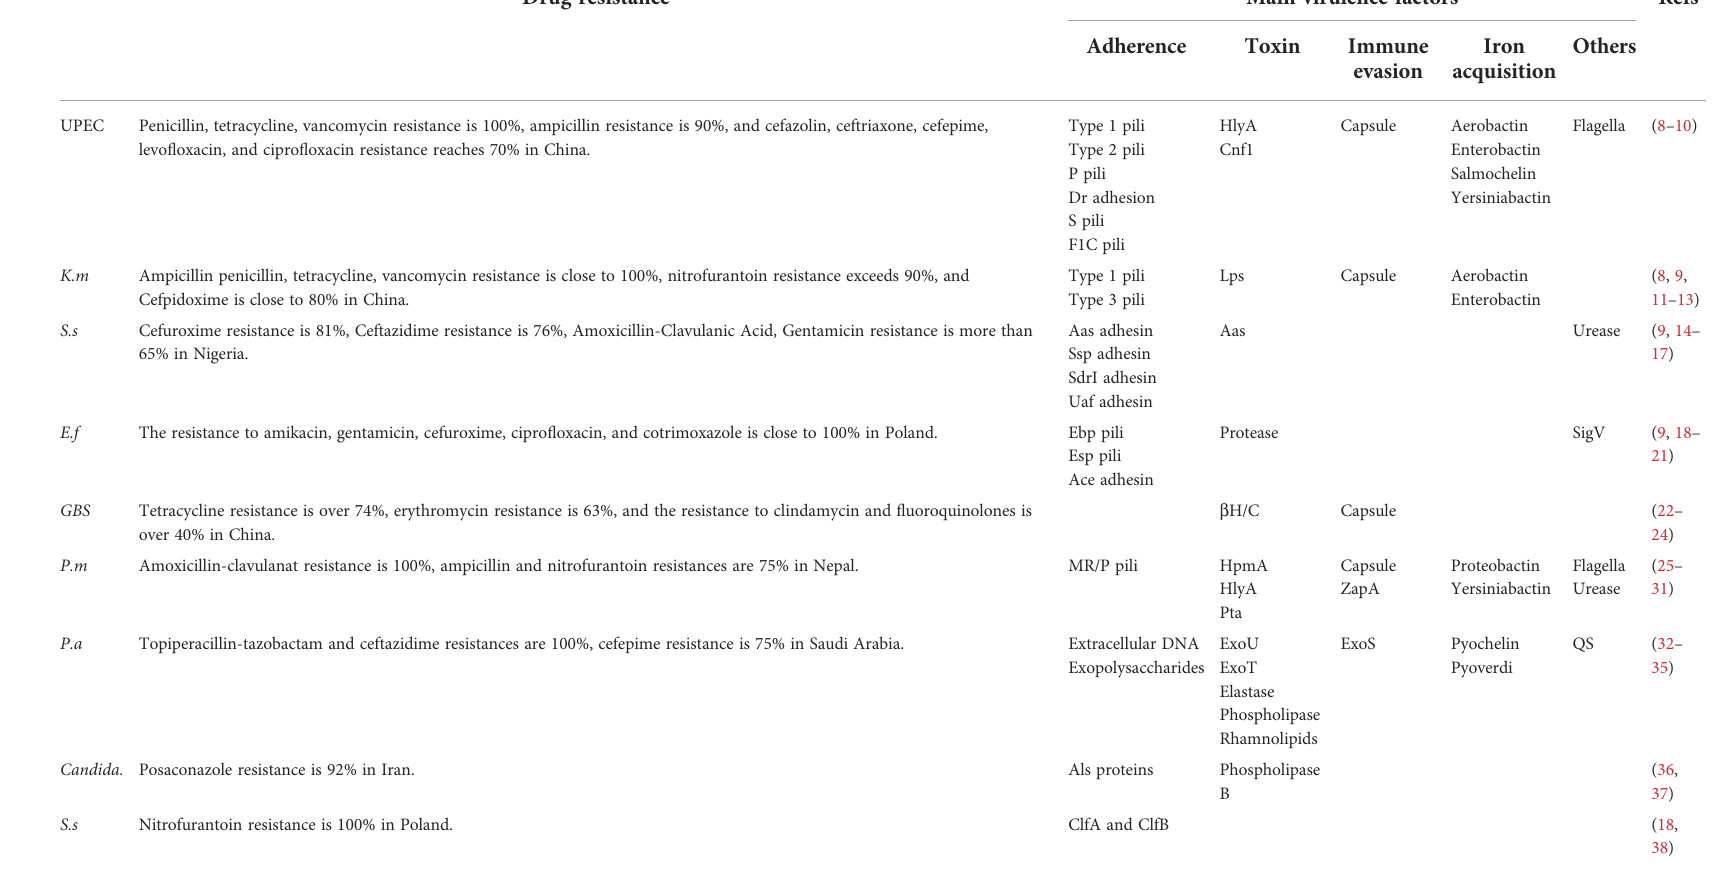
TABLE 1 Drug resistance and virulence factors of the main nine